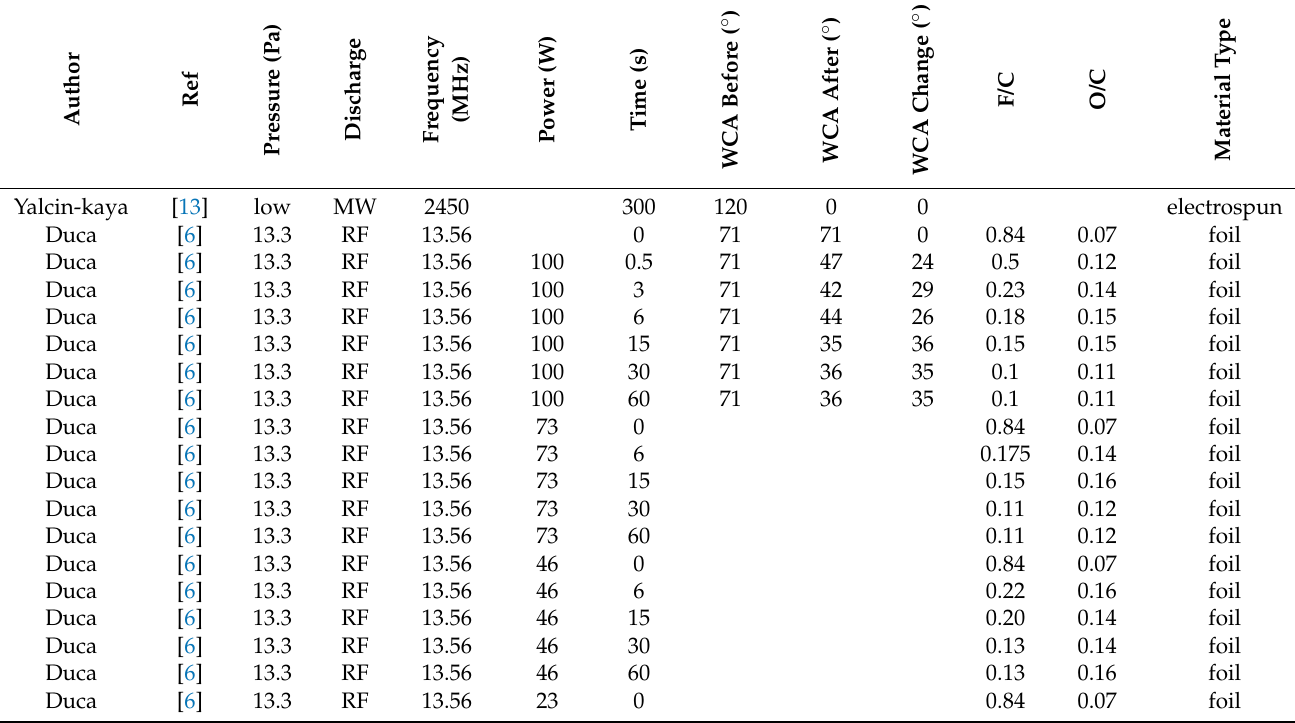
Table 1. Summary of results reported by various authors who have probed argon-plasma treatment.